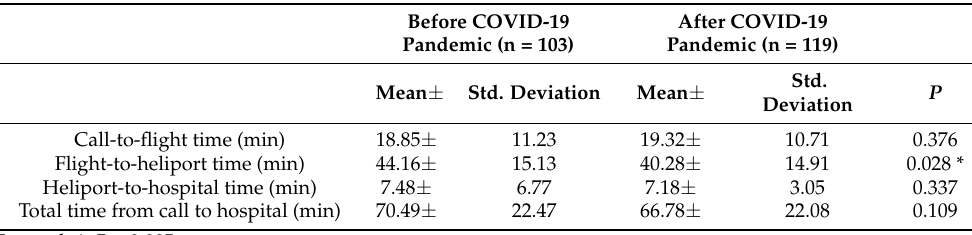
Table 4. Differences in transportation times before and after the COVID-19 pandemic, Student’s t test for independent samples, one-tailed.